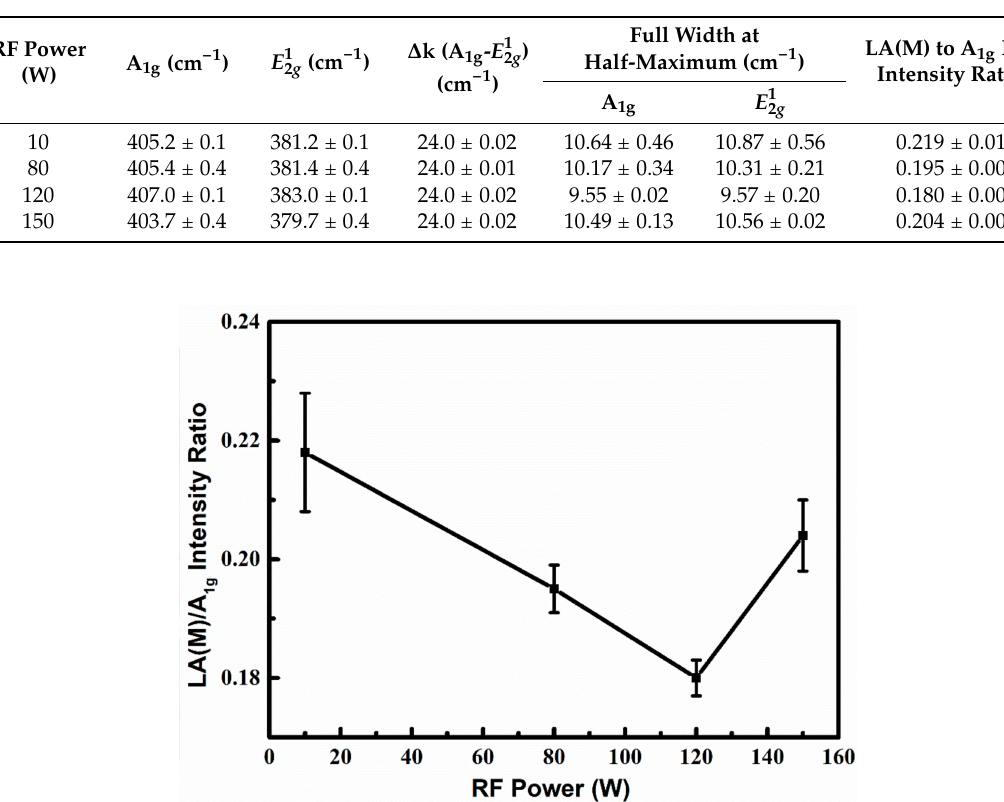
Table 1. The E 1 2 g - and A 1g -related Raman peak information of MoS 2 thin films deposited using radio frequency magnetron sputtering (RFMS) under various RF powers.